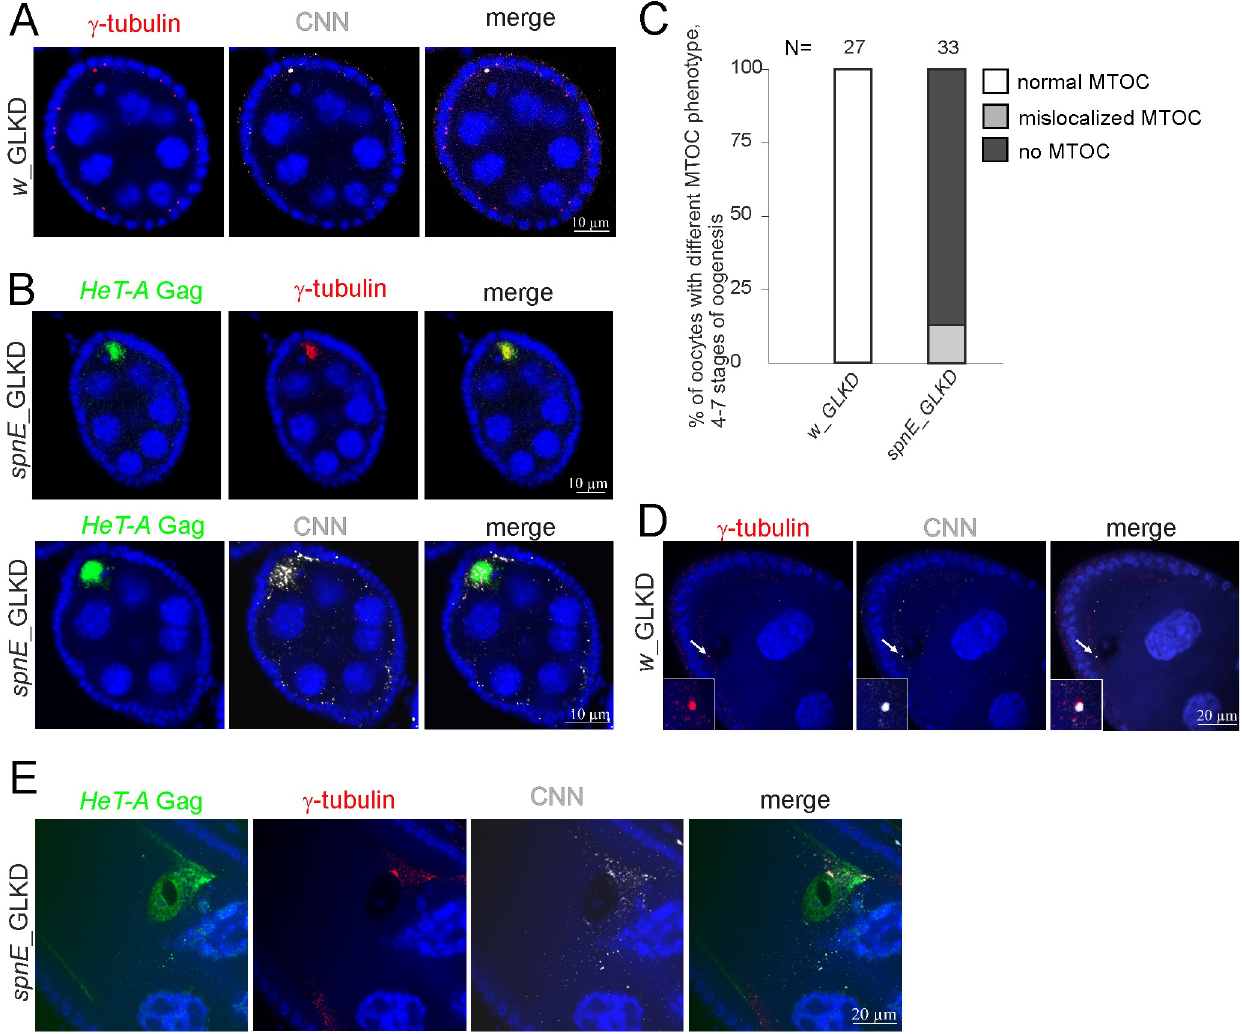
Fig 4. HeT-A overexpression caused by spnE knockdown is accompanied by centrosome dysfunction during oogenesis. (A) Co-immunostaining demonstrates colocalization of CNN (grey) and γ -tubulin (red) in the control ovaries ( w _GLKD). (B) Co-immunostaining demonstrates the localization of HeT-A Gag (green), CNN (grey), or γ -tubulin (red) in spnE _GLKD ovaries. Stage 6 of oogenesis is shown (A, B). (C) Bar diagrams show the MTOC phenotype (%) observed at 4–6 stages of oogenesis in spnE _GLKD. (D) Co-immunostaining of CNN (grey) and γ -tubulin (red) shows the centrosome reduction at stage 9 of oogenesis in w _GLKD ovaries. (E) Immunostaining reveals the accumulation of HeT-A Gag (green) and mislocalized CNN (grey) and γ -tubulin (red) at stage 10 of oogenesis in spnE _GLKD. The blue color indicates DNA.